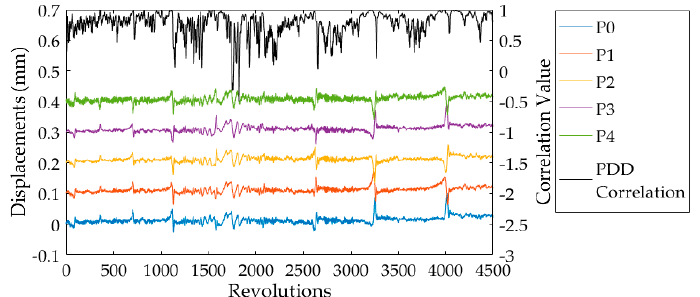
Figure 12. Identification results of blade 6# using the probe displacement distribution (PDD) correlation method.